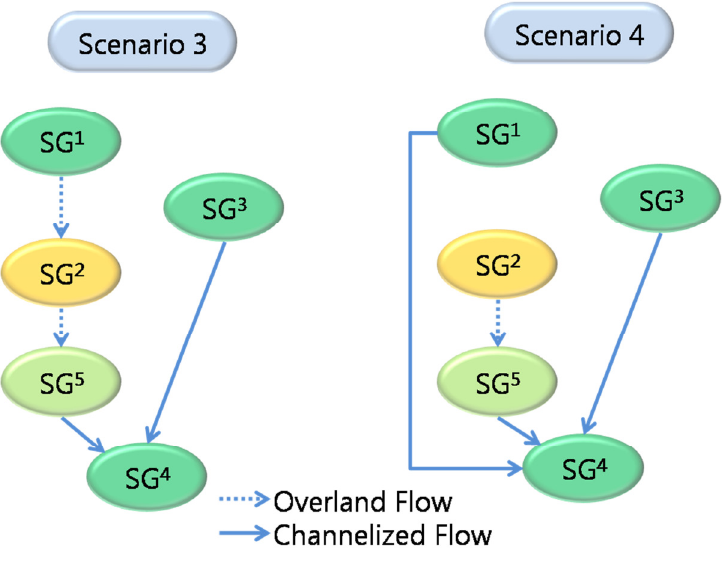
Figure 14. Watershed Configuration for VFS and Diversion Channel with VFS Simulation with Enhanced SWAT.